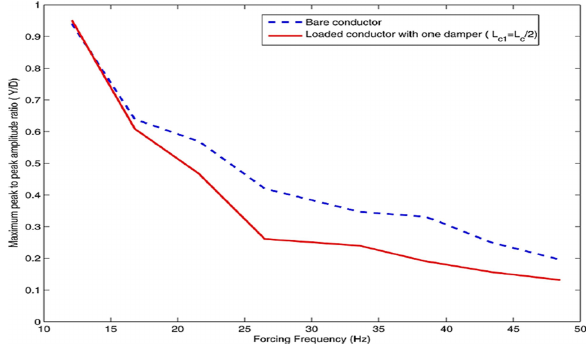
Figure 6: Shuddering retort of a archetypal extent length of trans- mission line